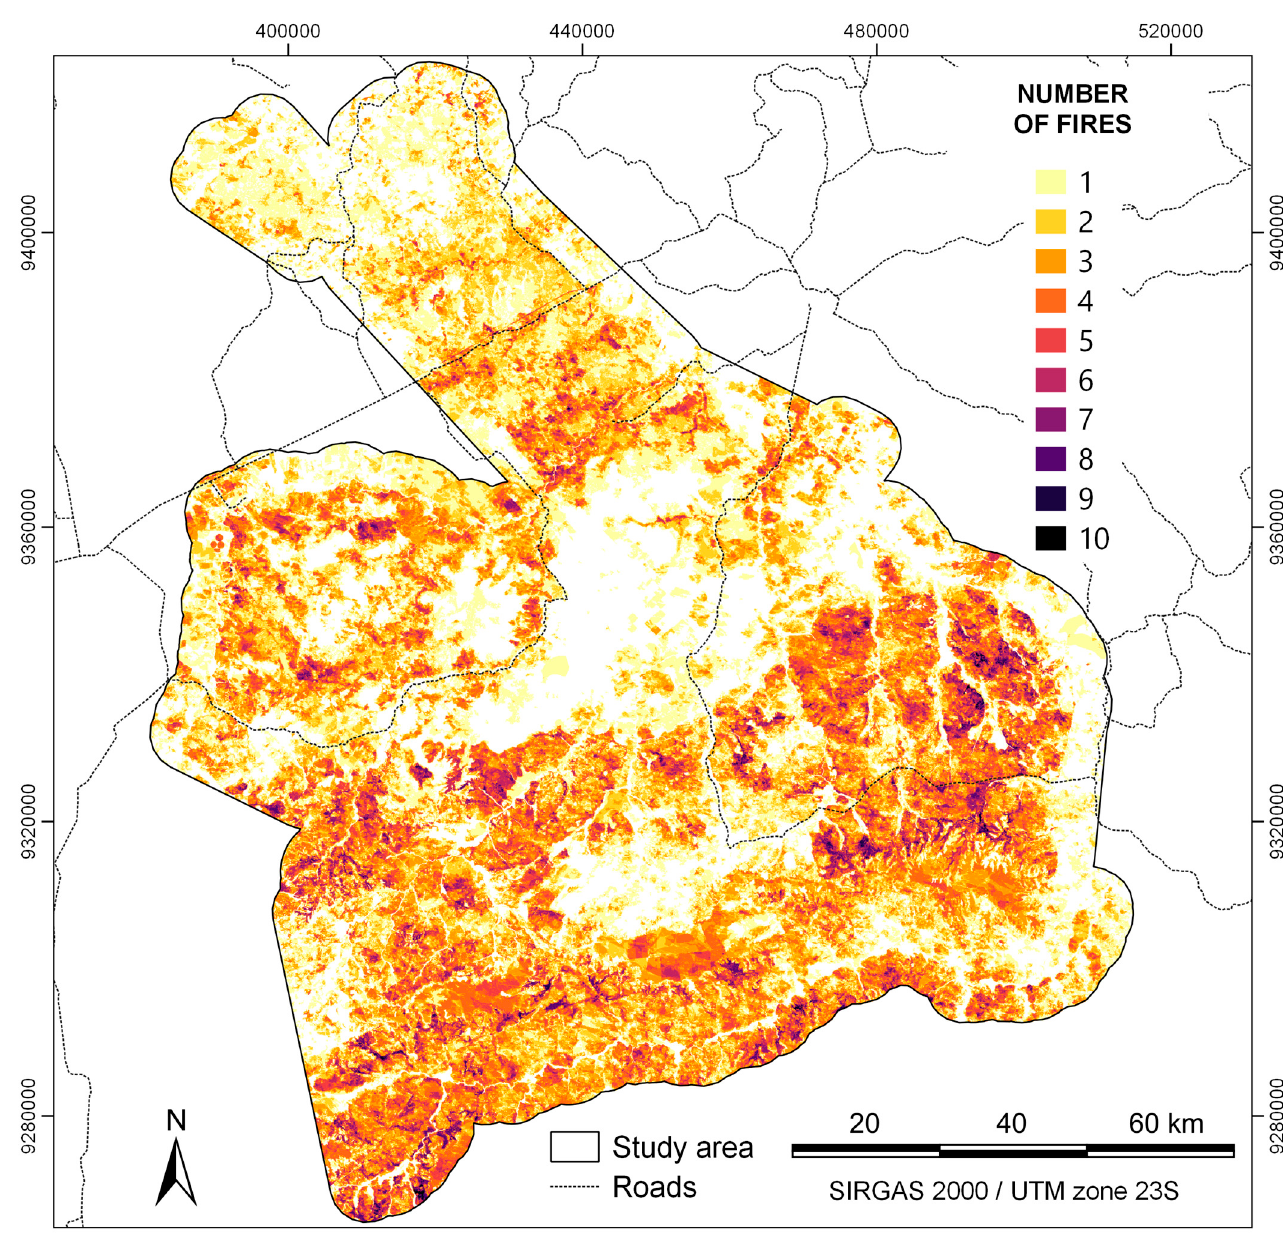
Figure 7. Mapping of fire recurrence from 2008 to 2017 in the ILs and its surroundings. The palette of colors represents the number of times that the same area burned. White areas were never burned during this period. Landsat 5 TM, Landsat 7 ETM+ and Landsat 8 OLI images were used for the delimitation of burned areas. Spatial resolution is 30 m.